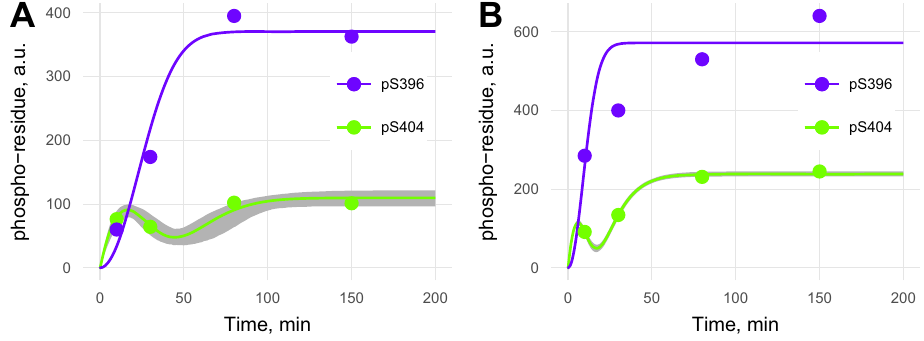
Fig 5. Phosphorylation kinetics of S396 (purple) and S404 (green) of tau (A) or PKA-prephosphorylated tau (B) by GSK3 β . Kinetics for pS404 with 95% confidence bands are represented. Errors of experimental values were not provided by the authors [20].